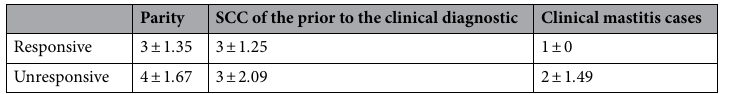
Table 3. The median and standard deviation values of the external feature metric for both classes.